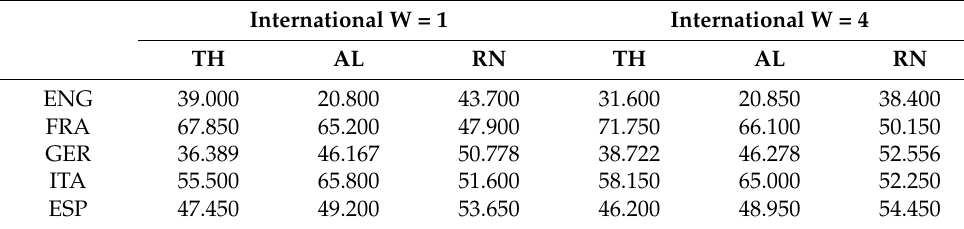
Table 10. Average ranking positions of the teams by nation.